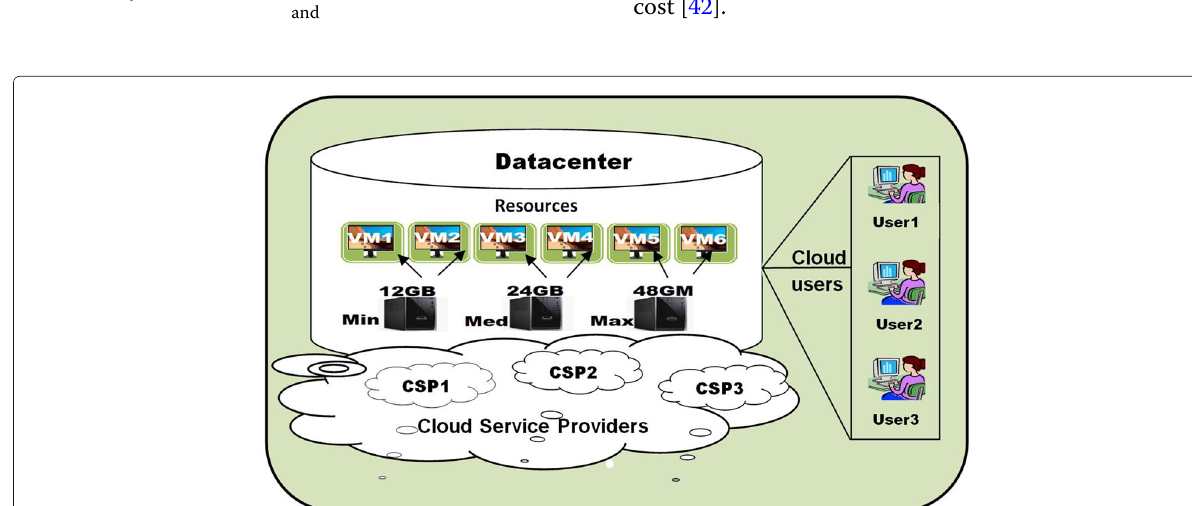
Fig. 2 Cloud resource